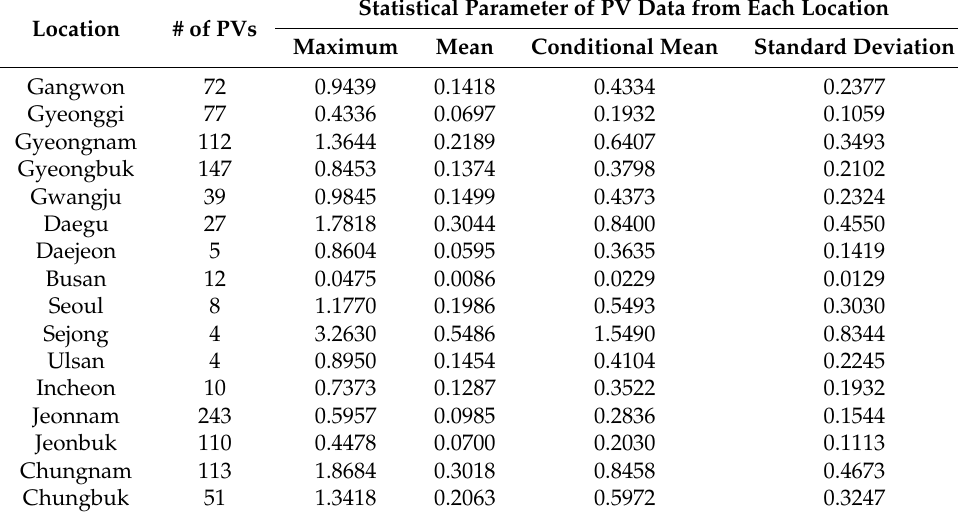
Table 1. Statistical information of the PV sites in Korea. Statistical Parameter of PV Data from Each Location Location # of PVs Maximum Mean Conditional Mean